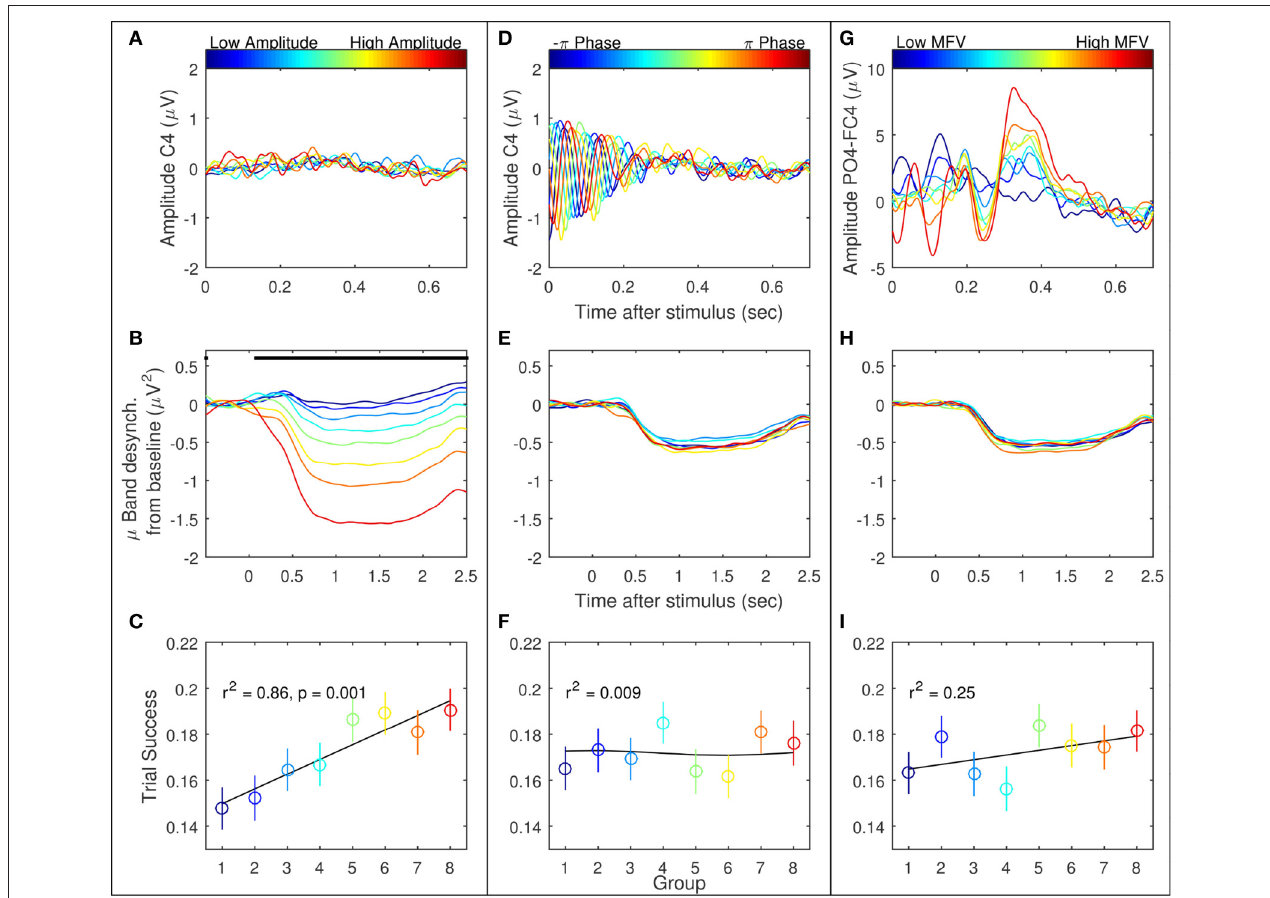
FIGURE 5 | Three EEG features were considered as potential gating variables (shown here are the right hemisphere features): mu amplitude in C4 at stimulus presentation (left column, A–C), mu phase in C4 at stimulus presentation (middle column, D–F), and match to PO4-FC4 VEP template (right column, G–I). For each feature, all recorded trials were divided into eight groups, from low feature value to high, represented by the eight colored lines/points. The first row is the average of the EEG in these groups. The second row is the average mu suppression from baseline in C4 in these groups. The last row is the mean and standard error of the success across all trials by